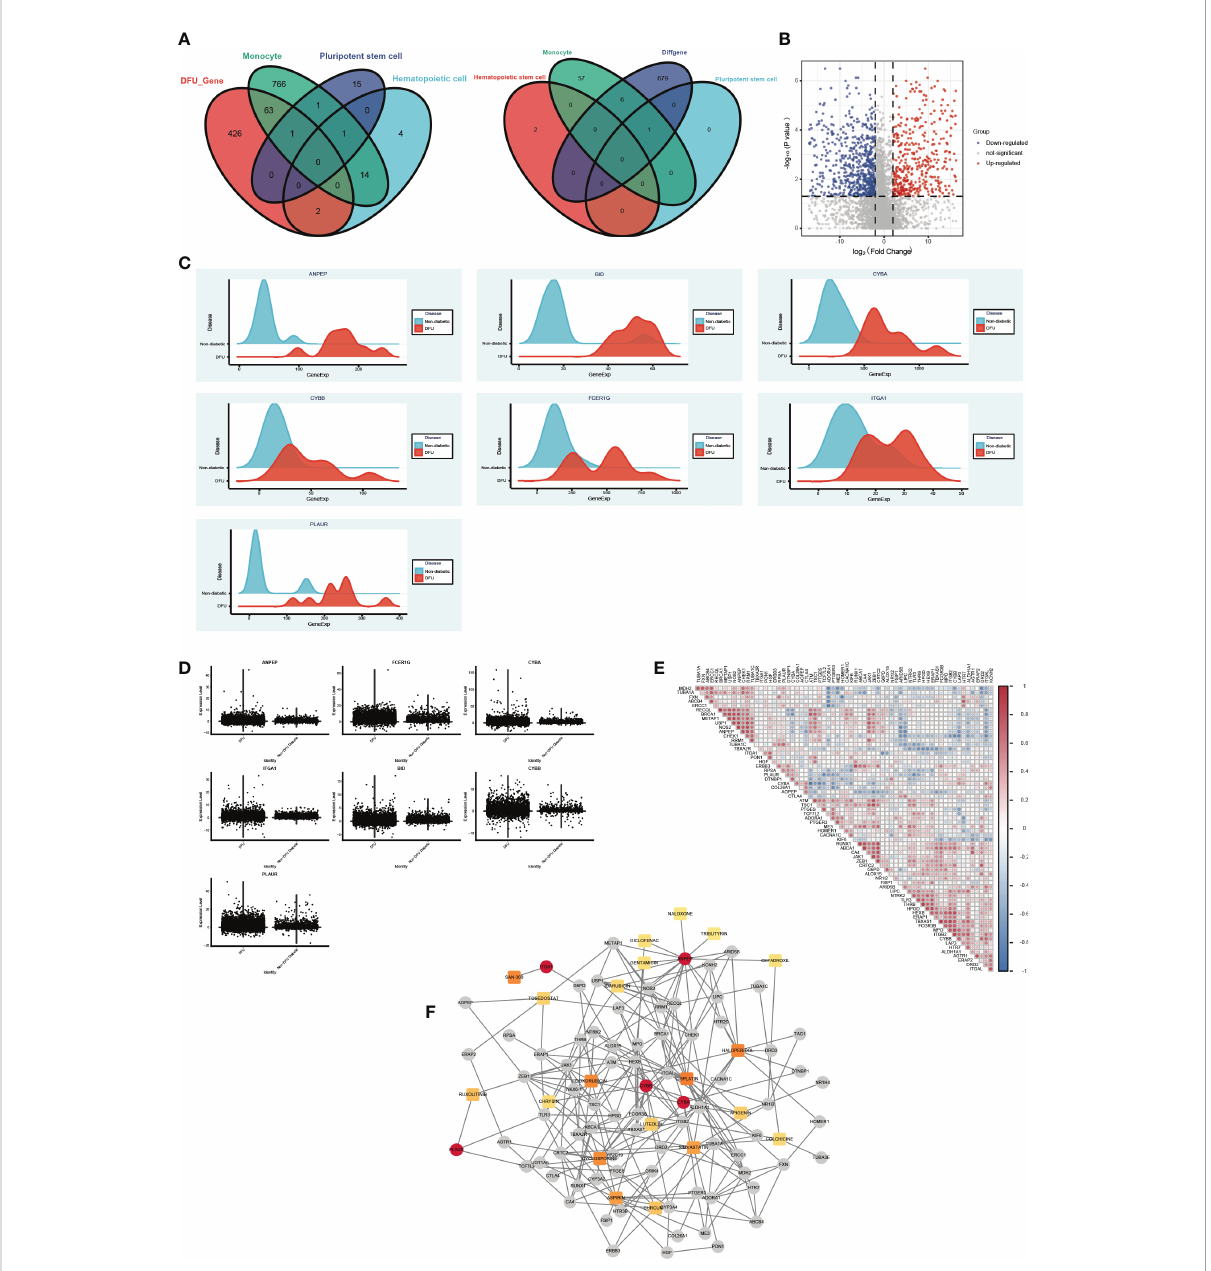
FIGURE 7 The drug gene network analysis. (A) The Venn diagram shows the intersections of DFU genes (left) and DEGs (right) between Monocyte cells, Pluripotent stem cells and Hematopoietic cells mark genes. (B) The Volcano plot shows the drug target differential expression genes. Blue, down- regulated, Red, up-regulated. (C) The ridge plot of drug genes between DFU and Non diabetic tissues. (D) The boxplot diagram of drug genes between DFU and Non diabetic tissues. (E) The Spearman correlation coef fi cient between medications and their intended targets. (F) Drug genes and drug gene networks using the DGIdb